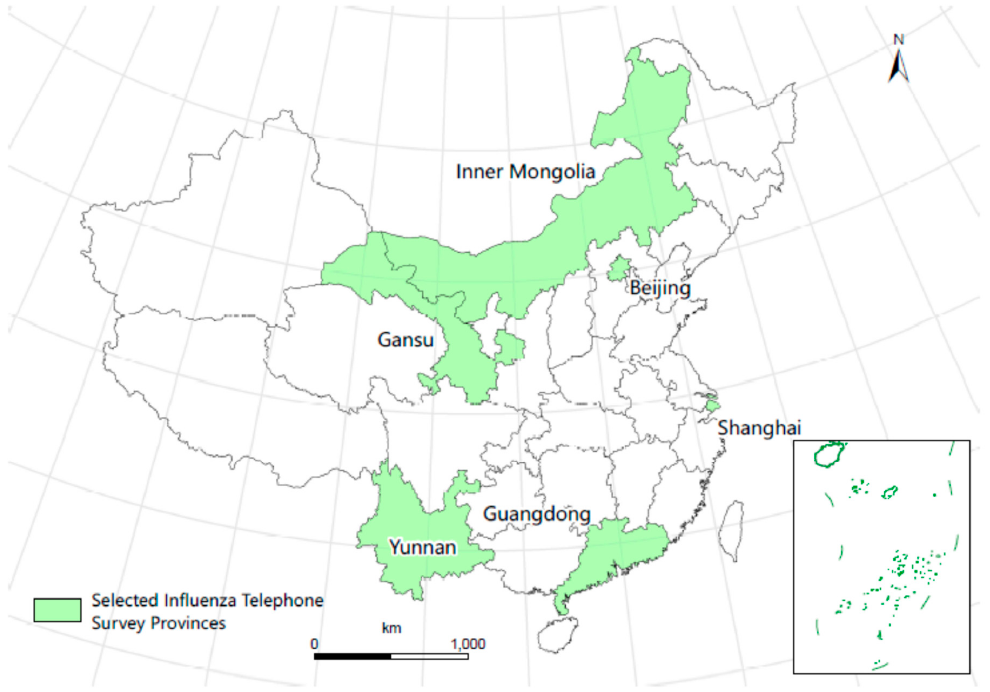
Figure 1. Map of the six selected provinces in the influenza-like illness survey in China, 2017/2018.